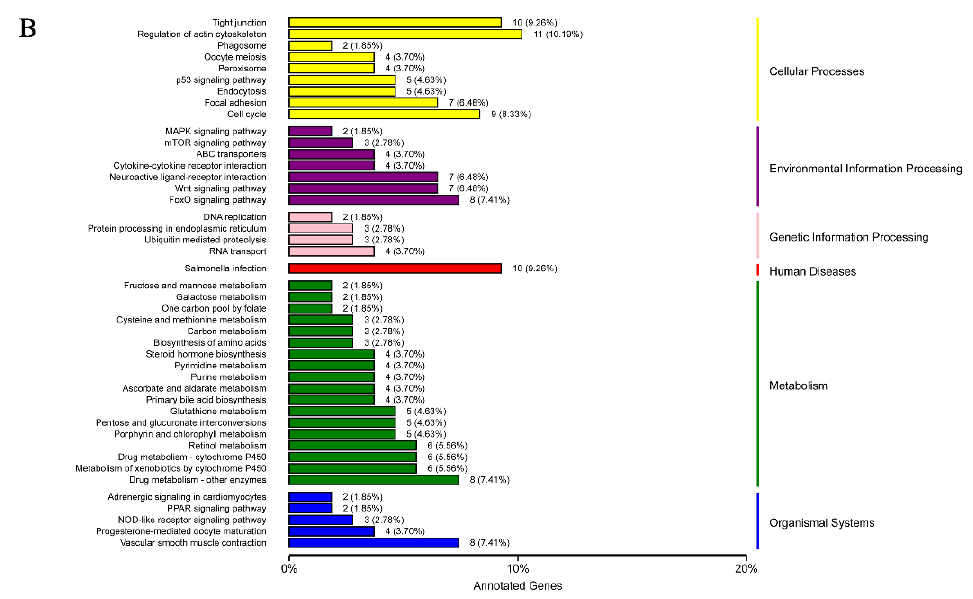
Figure 6. KEGG enrichment and classification. ( A ) Scatter plot of KEGG pathway enrichment results for differentially expressed genes: the ordinate represents the pathway name, the abscissa represents the enrichment factor, and the color represents the q-value (i.e., the p -value after correction for multiple hypothesis testing). The size of the circle indicates the number of genes involved in the pathway. ( B ) KEGG classification diagram: the left-hand vertical axis shows the KEGG pathway name, and the right-hand vertical axis shows the category corresponding to each pathway. A shared column color indicates the same category.